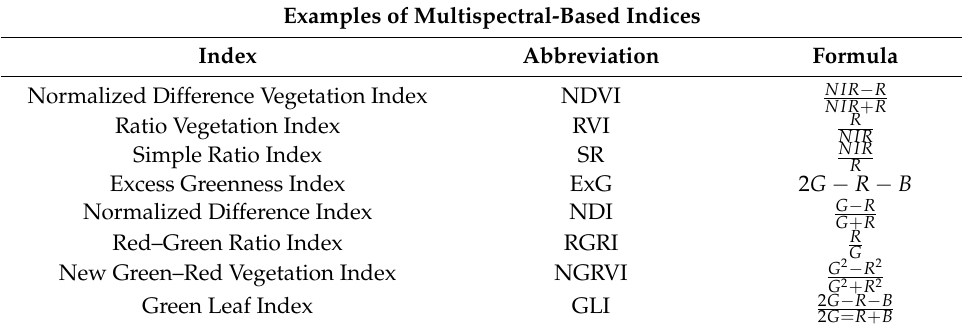
Table 4. Examples of visible-spectrum- and multispectral-based indices. Examples of Multispectral-Based Indices Index Abbreviation